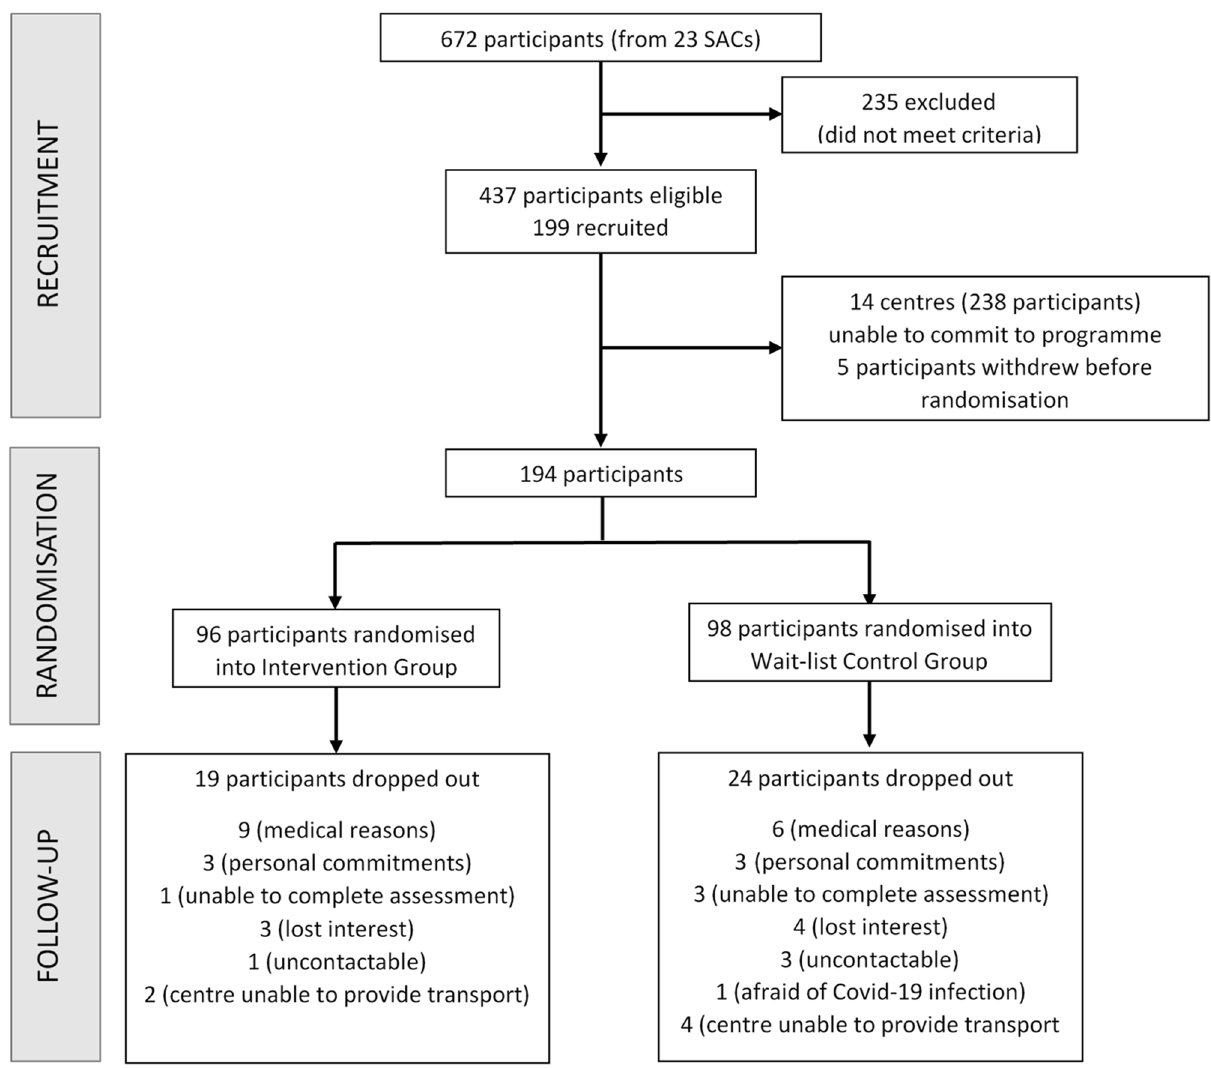
Figure 1. Participant flow diagram from initial contact to end of